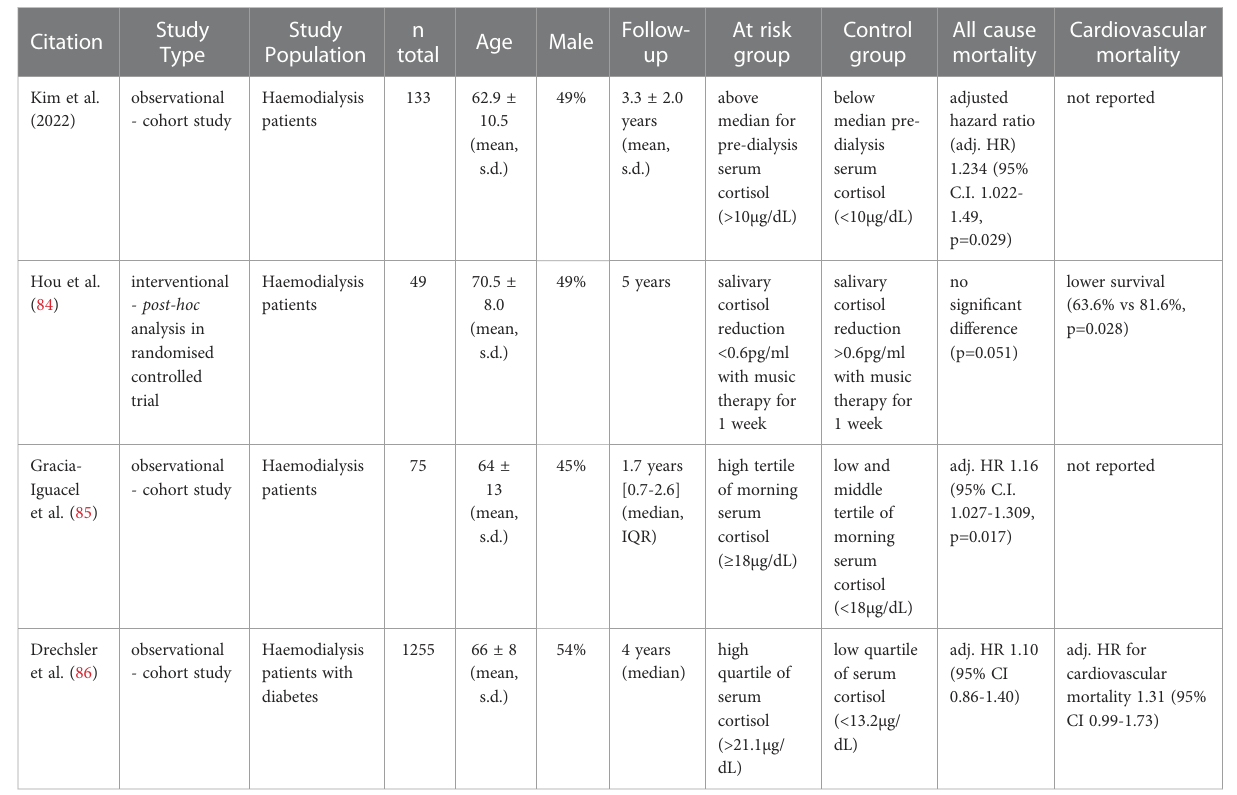
TABLE 5 Associations between cortisol and survival in